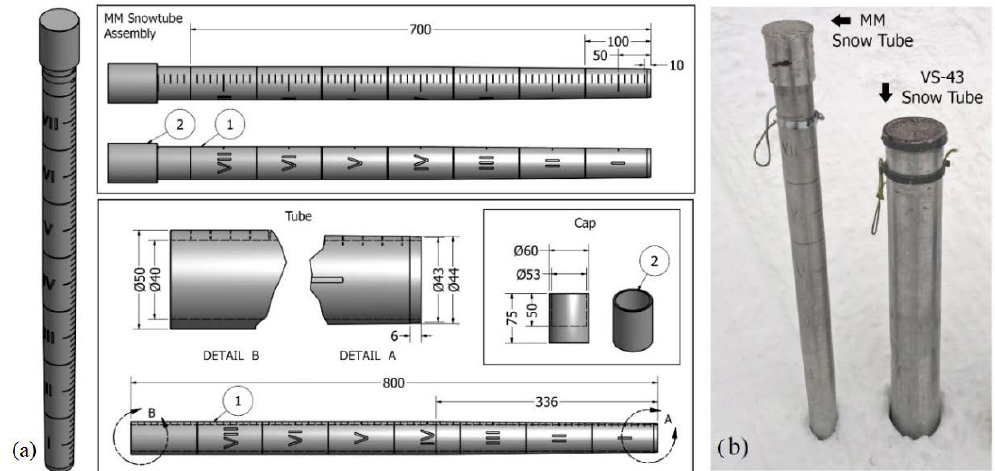
Figure 2. ( a ) Assembly of the MM snow tube, which consisted of a tube and cup (dimensions in mm); ( b ) Commonly used VS-43 snow tube in comparison with the designed tube.